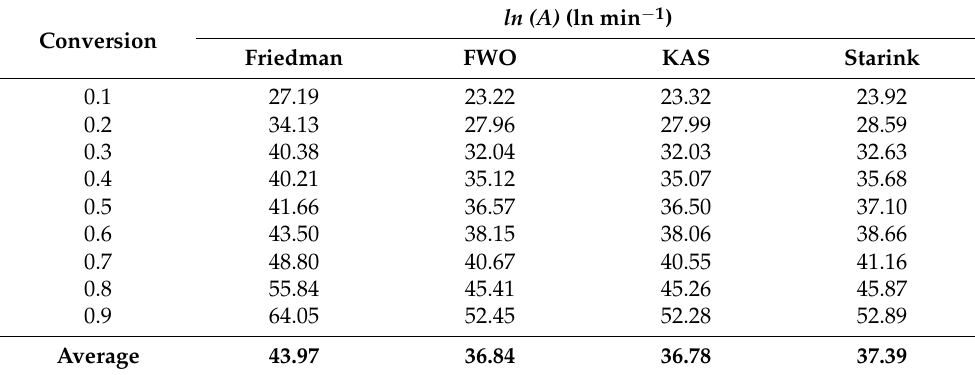
Table 10. Pre-exponential factor of the co-pyrolysis of PS, PP, and LDPE (tests 4–6).